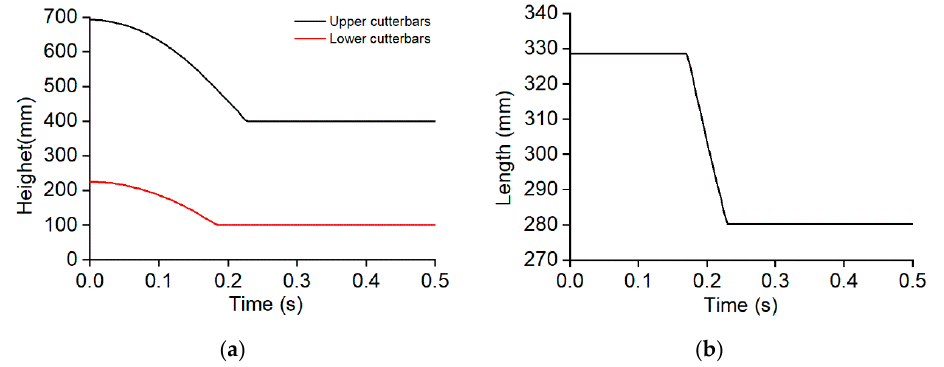
Figure 12. Motions of the components with the DCH descending. ( a ) Height change of the upper and lower cutterbars; ( b ) Length change of the L BA .